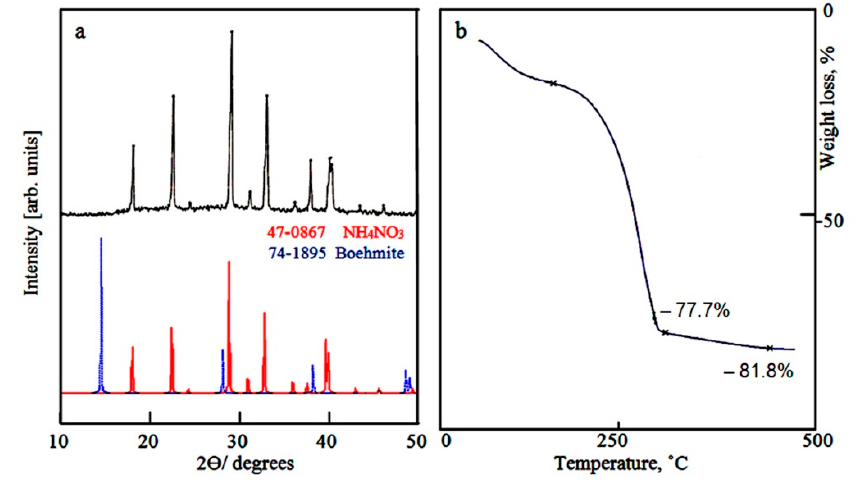
Figure 1. The dried product: ( a ) X-ray diffraction and ( b ) Thermal gravimetric analysis.